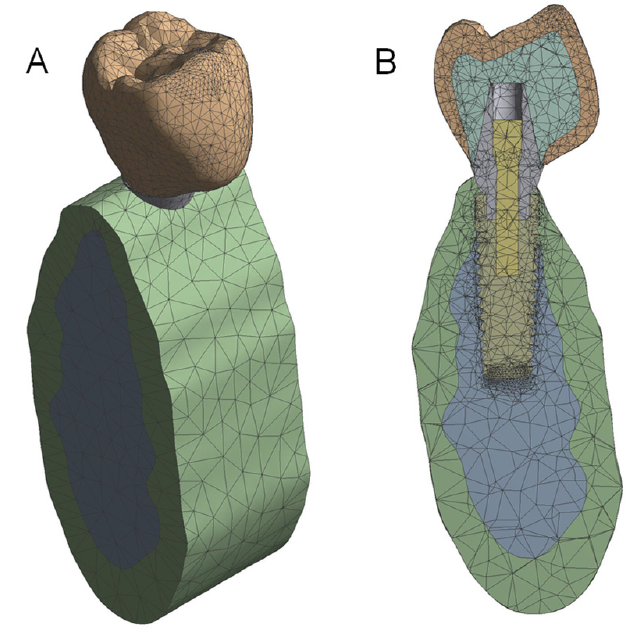
Figure 1. View of the whole 3D FEA model ( A ). Sectional model ( B ). The prosthesis-implant-bone model was simulated to collide with a 10 × 12 × 2 mm fixed and rigid plate at a speed of 1 m/s after a displacement of 0.01 mm. For accurate results, the size of the elements is very important. The FEA model had 96,160 nodes and 62,606 elements to simulate the real models (prosthesis, implant, and bone) (see Figure 1). Young’s modulus, Poisson’s coefficient, and density were assigned to each material used